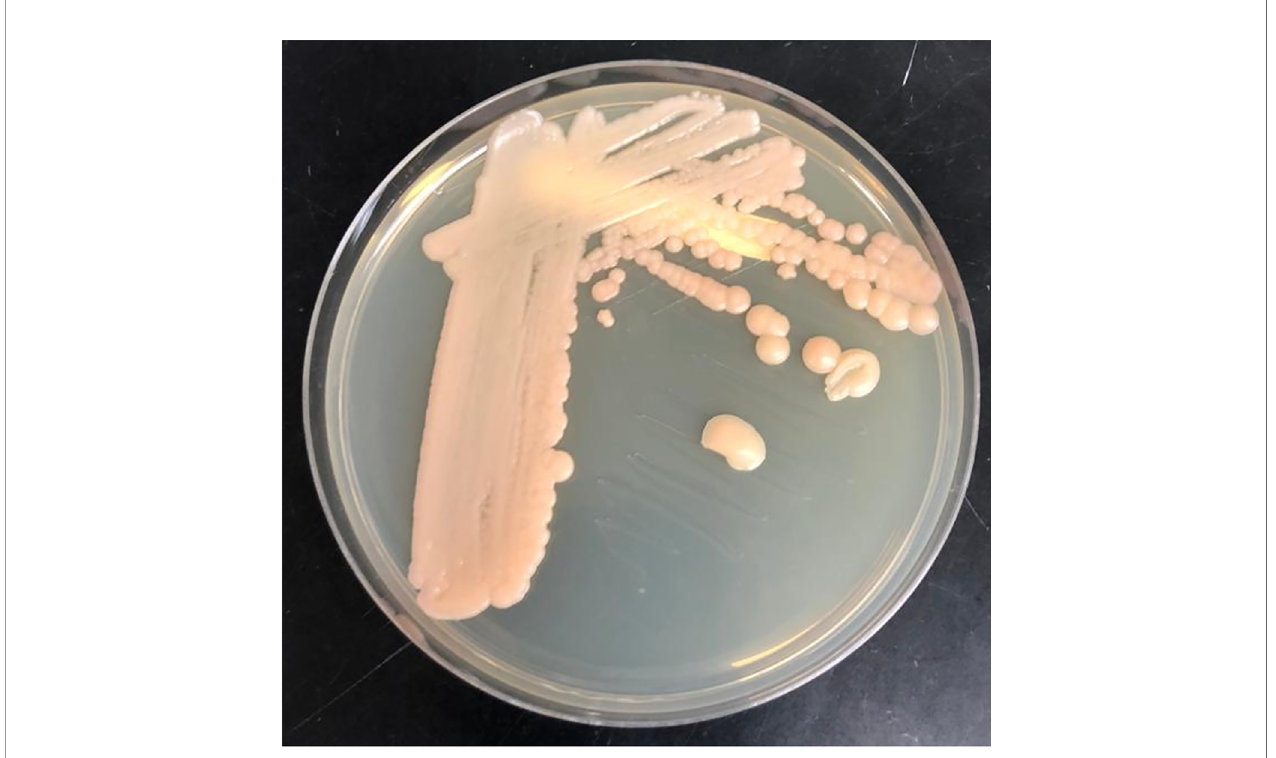
FIGURE 2 | Phenotypic characteristics of Naganishia sp. after 48 h of incubation at 30° in YPD medium showing creamy colonies with an unusual pink